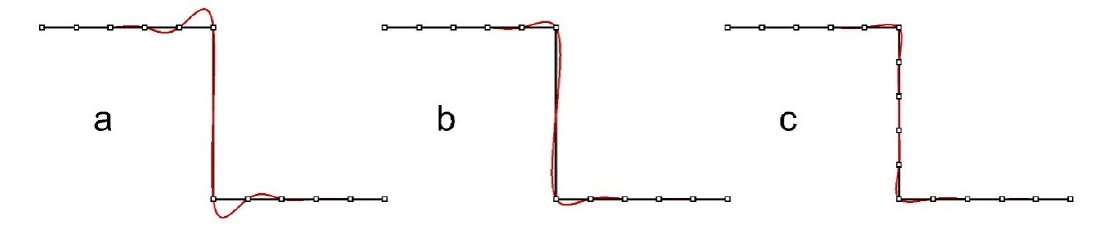
Figure 13. Two-edge configurations: with a gap (knot vector: ( a )—uniform, ( b )—centripetal), ( c )—ordinary two-edge configuration with no gap in points.